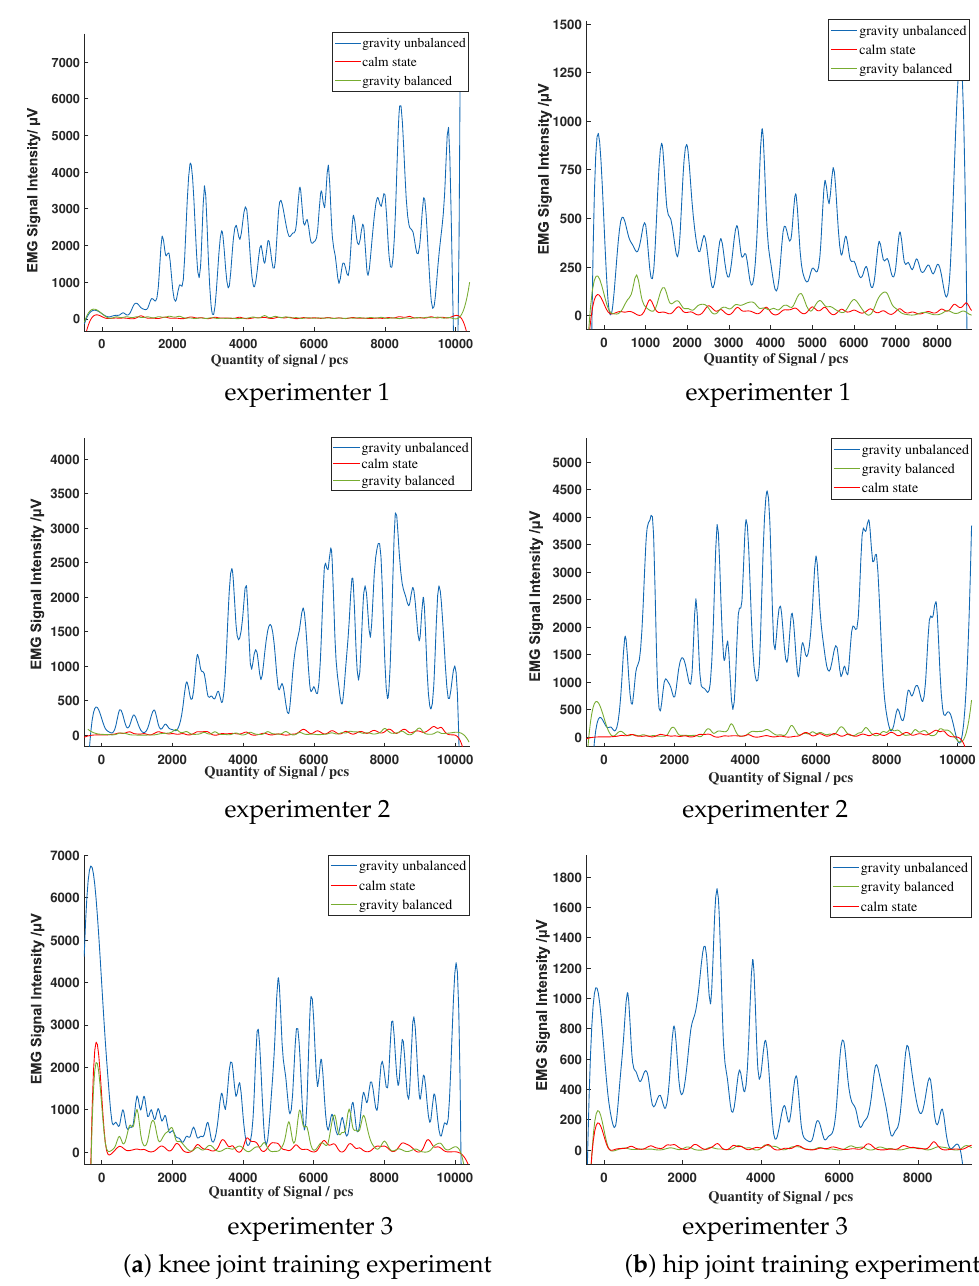
Figure 14. EMG signal variation of subjects during rehabilitation training